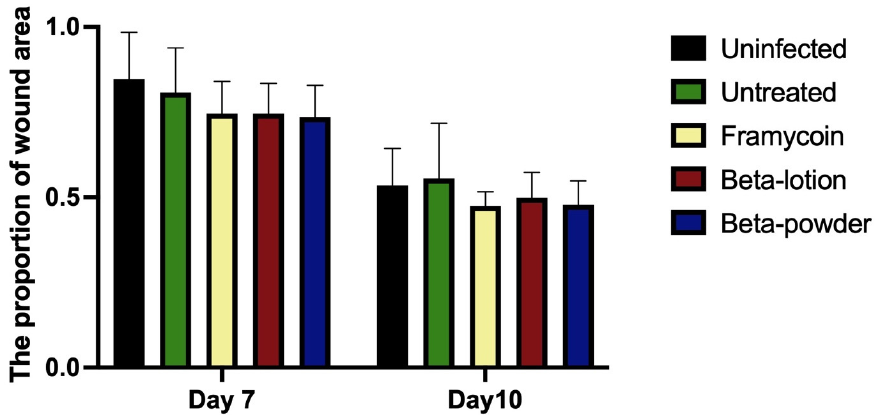
Figure 3. The effect of antibacterial treatments on the wound area. Areas of the individual wounds on days 7 and 10 were related to the respective wound area at the beginning of the experiment. The data are presented as means and standard deviations using the nonparametric Kruskal–Wallis test and multiple comparison test.